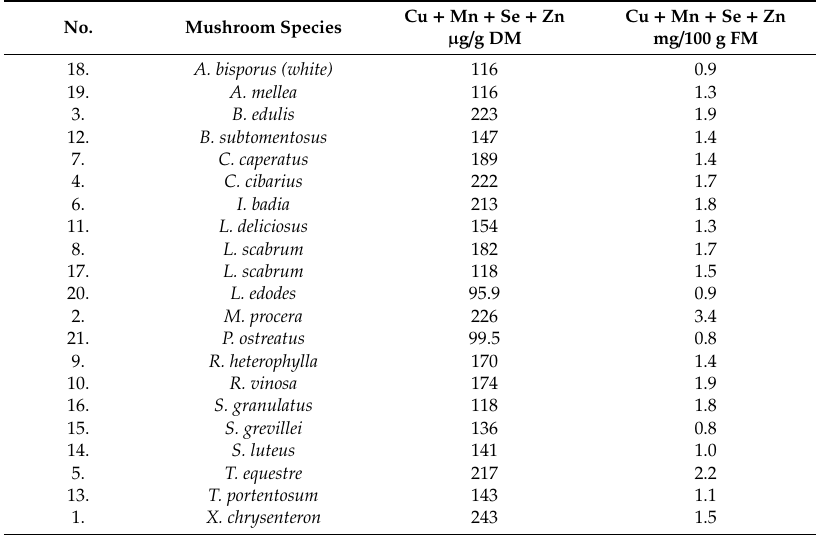
Table 3. Total microelement content in the dry and fresh mass of the studied mushrooms.